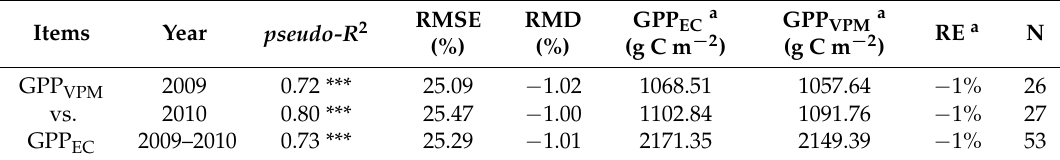
Table 1. The evaluation of model simulation results in the typical coastal wetland. Four statistical criteria for the validation tests: pseudo- R 2 , the coefficient of determination; RMSE, the root of mean square error; RMD, the relative mean deviation; and, RE, the relative